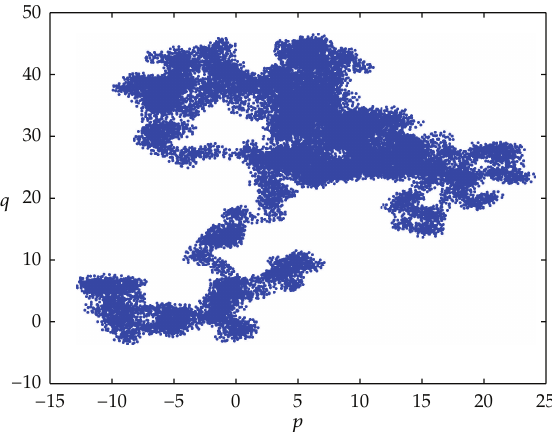
Figure 3: Plot of p versus q for the DCML (cid:3) 3.18 (cid:4) with (cid:2) (cid:8) 0 . 03. We used 30000 data points of x (cid:3) 111 (cid:4) .